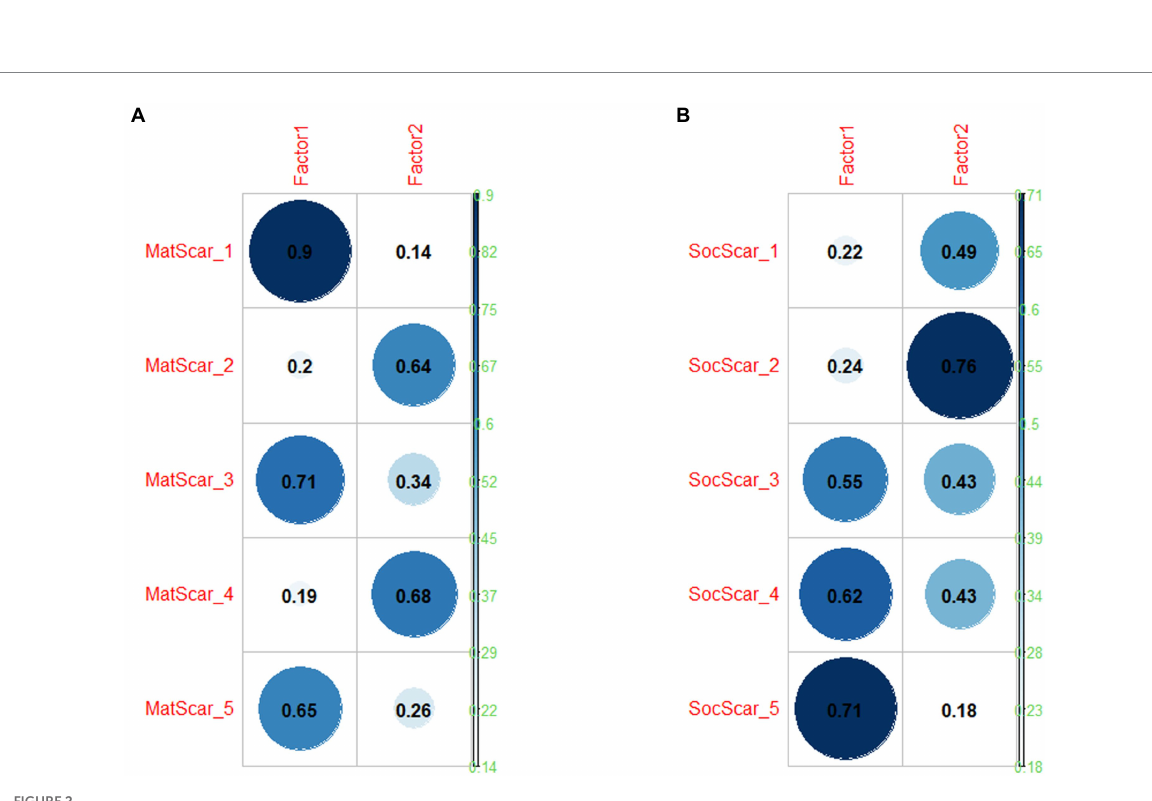
FIGURE 2 Factor loadings for each item: (A) Material Scarcity loadings; (B) Socio-Psychological Scarcity